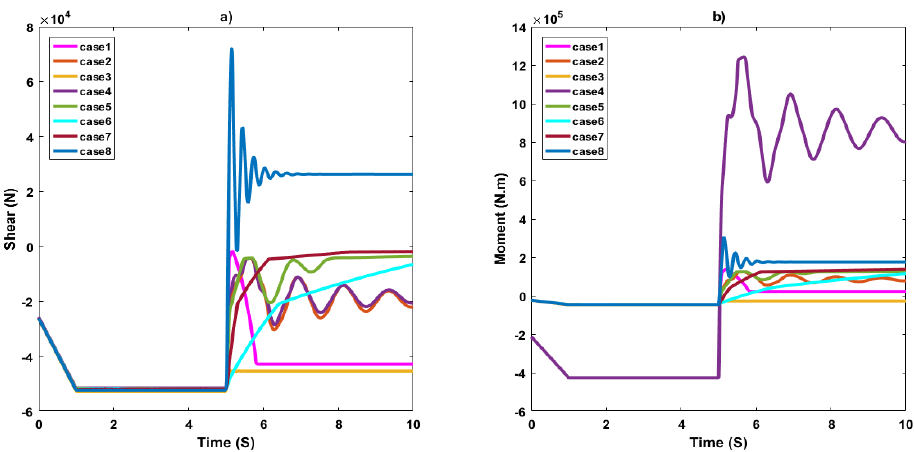
Figure 19. Beam behavior after column removal in story one: ( a ) shear and ( b ) moment. In the first and sixth stories, the beam shear force for the bare frame (Case 1) is less than the other cases (see Figures 18 and 19). This is because the joint stiffness of CFRP frames attracts more force. In other circumstances, pressures are evenly dispersed overall plot levels. As a result, having a CFRP framed structure minimizes the axial force de- mands in a simple jointed beam, enhancing the CFRP frame's progressive collapse re- sistance due to column loss. The bending moment value for the viscously damped frame in two inner bays on floor thirteen is more than the bending moment for CFRP framed, as shown in Figure 20. Because of the stiffness, Case 8 performs well against progressive collapse, although there are many moments in the column adjacent to the brace, necessi- tating the employment of a less rigid brace. Viscous dampers were able to lower bending moment forces and provide effective energy absorption in the circumstances where they were applied.